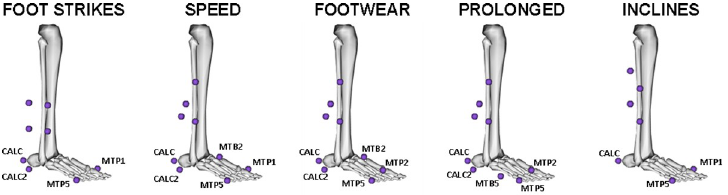
Fig 1. Tracking markers used for each dataset. The shank was tracked using clusters at different positions and different marker configurations. CALC: calcaneus, CALC2: lateral calcaneus, MTB5: 5th metatarsal base, MPT5: 5th metatarsal head, MTB2: 2nd metatarsal base, MTP2: 2nd metatarsal head, MTP1: 1st metatarsal head.